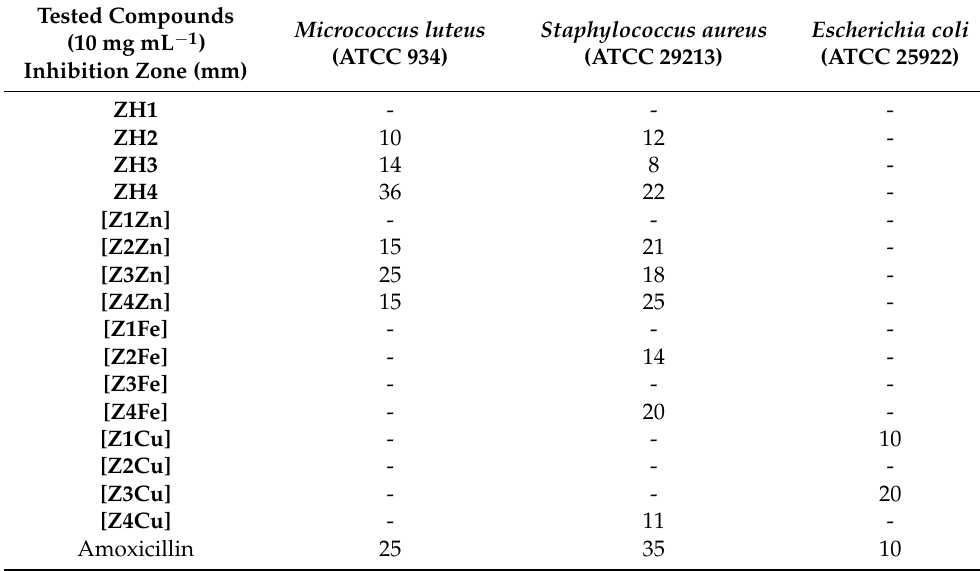
Table 2. The antimicrobial activity as shown by the inhibition area in the tested compounds. Tested